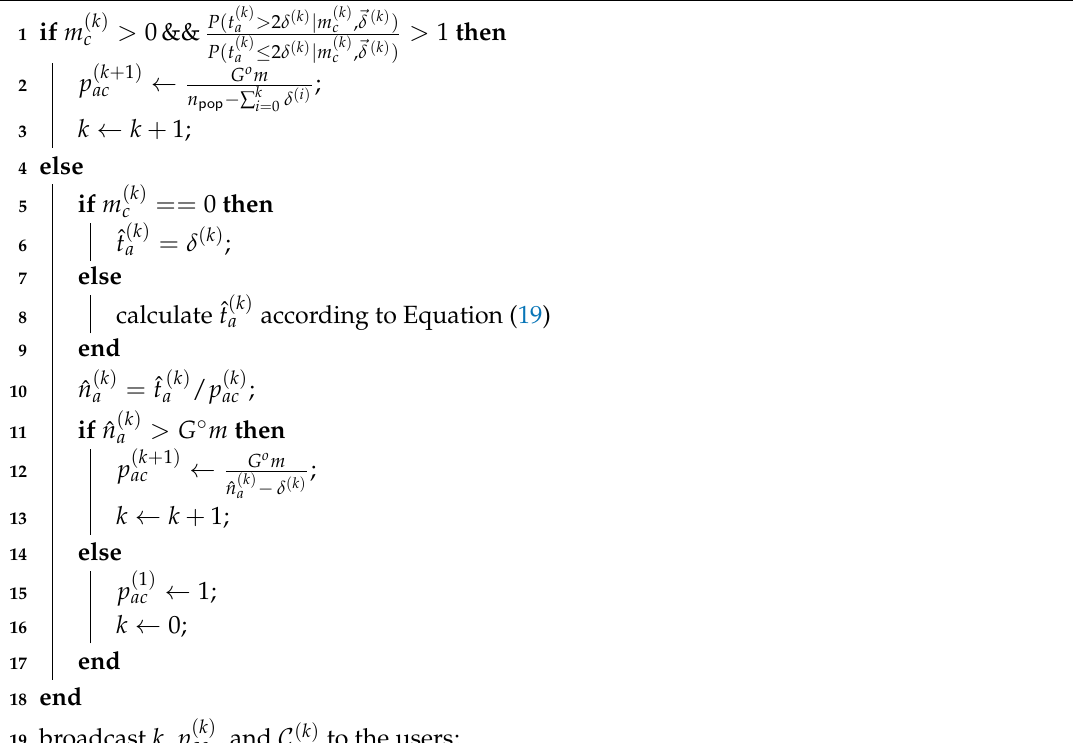
Algorithm 1: Receiver